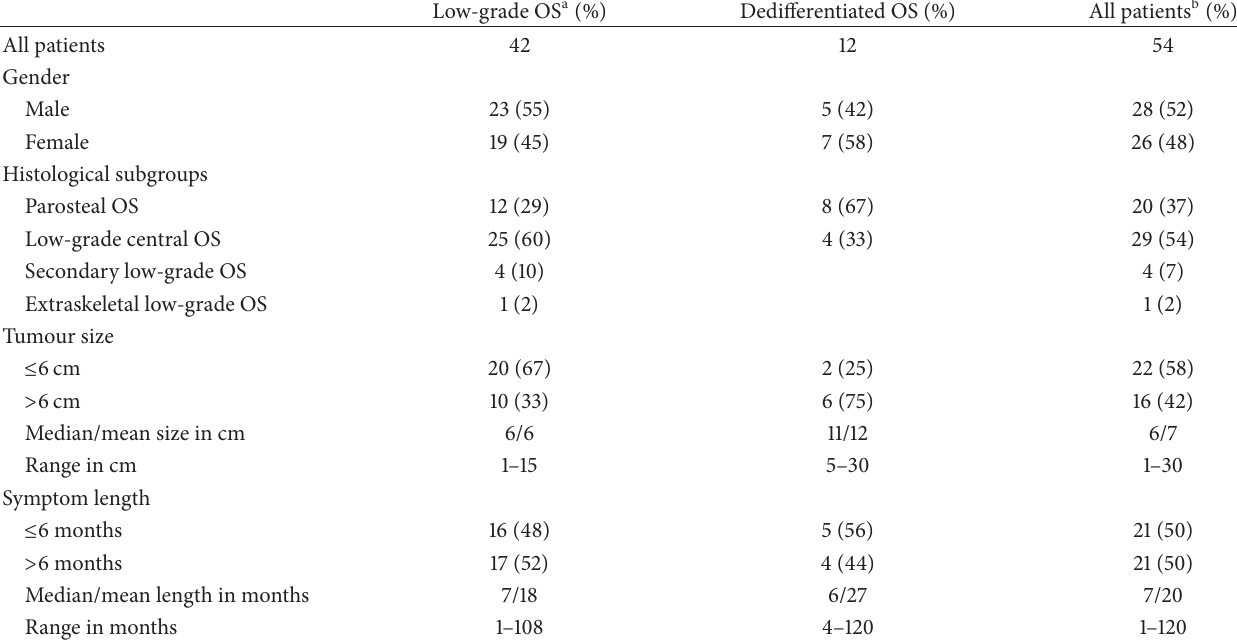
Table 1: Clinicopathological variables in 54 low-grade and dedifferentiated osteosarcoma (OS) patients.